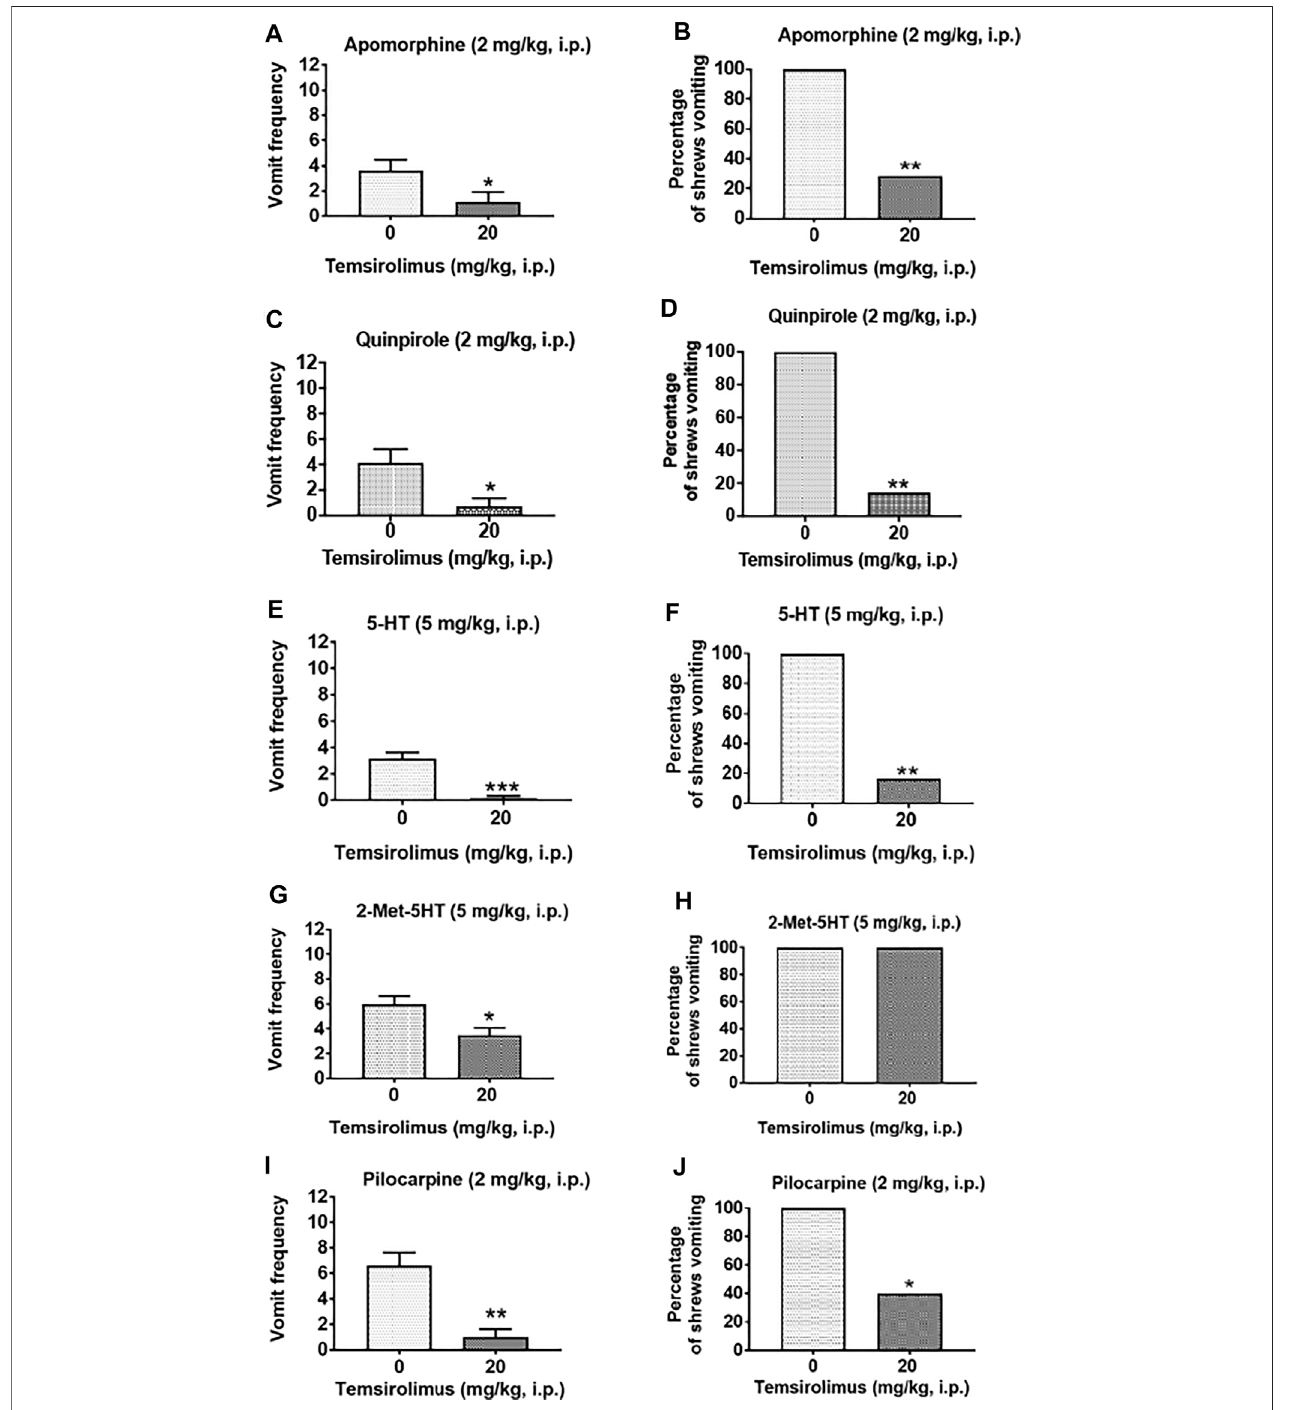
FIGURE4| Broad-spectrum antiemeticpotentialoftemsirolimus.Differentgroupsofshrews werepretreatedwitheithertemsirolimus(20 mg/kg, i.p.) orits vehicle (i.p.) Thirty min prior to administration of amaximally effective dose of diverse emetogens known to evoke vomiting in all tested shrews. To varying degrees temsirolimus reduced vomiting in response to the cited emetogens. Data are presented as the mean frequency of vomits (±SEM) (graphs (A,C,E,G,I,K,M,O,Q,S,U) ) and the percentage of shrews vomiting (graphs (B,D,F,H,J,L,N,P,R,T,V) ) for the following emetogens respectively: apomorphine, quinpirole, 5-HT, 2-Me-5-HT, pilocarpine, McN-A-343, GR73632, FPL64176, thapsigargin, SR141716A, and cisplatin. Signi fi cant differences relative to the temsirolimus vehicle control group are indicated as * p < 0.05; ** p < 0.005; *** p < 0.001; **** p < 0.0001.